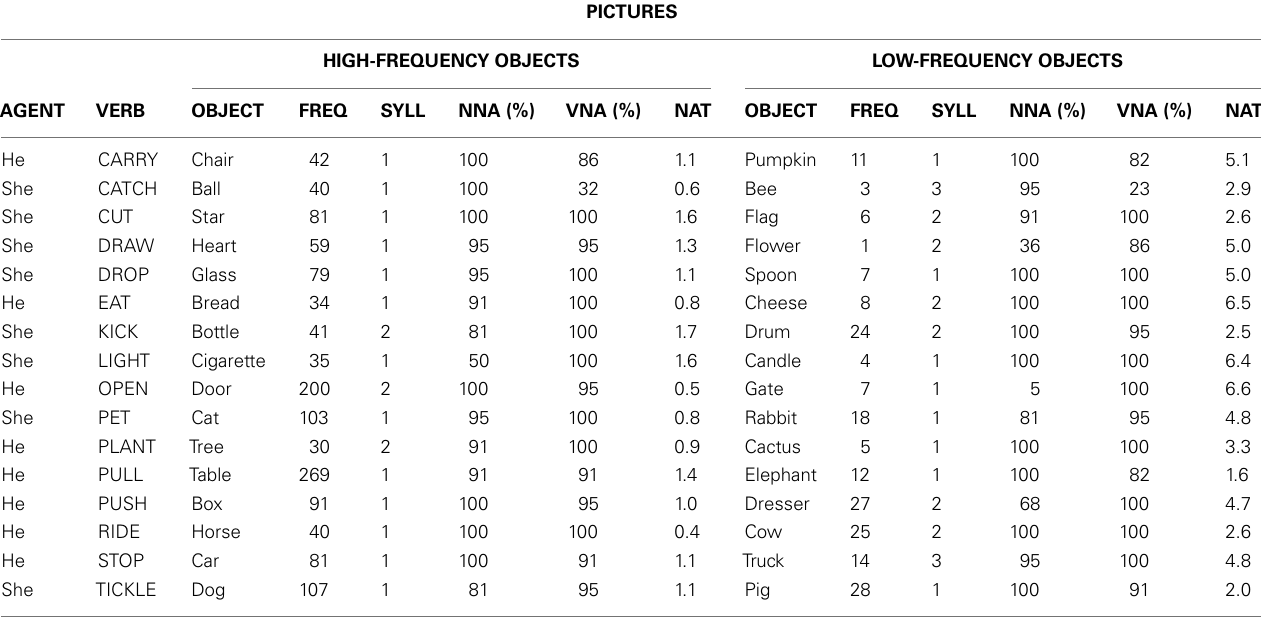
TableA2 | Stimuli for Experiment 2. Frequency (FREQ), number of syllables (SYLL), noun-naming agreement rating (NNA %), verb-naming agreement rating (VNA %), and naturalness rating